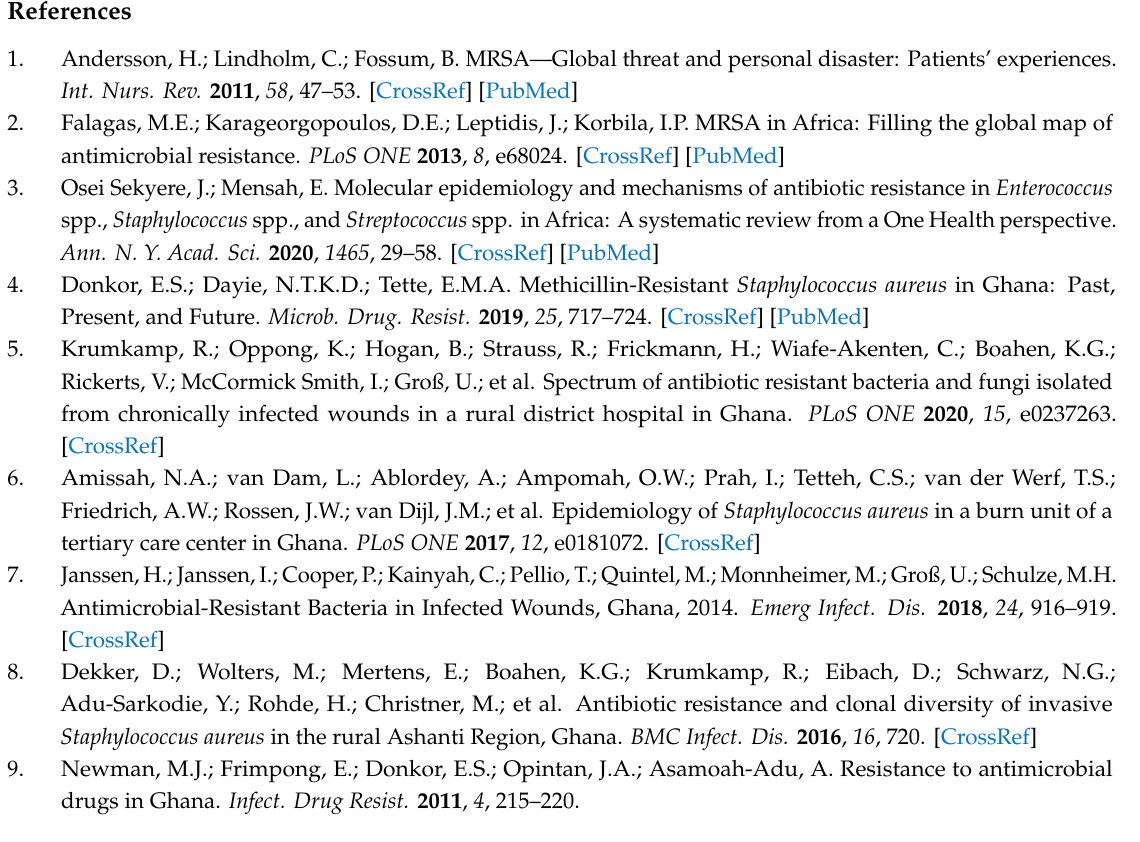
Table S1: Complete MLST, agr and SCCmec typing, virulence factor and resistance gene datasets (VFDB, Resfinder and NCBI AMR) and phenotypic AST results. VFDB, Resfinder and NCBI AMR: The numbers represent the percent identity in the alignment between the best matching resistance or virulence gene in ResFinder or VFDB and the corresponding sequence in the input genome. A perfect alignment is 100% and must also cover the entire length of the resistance gene in the